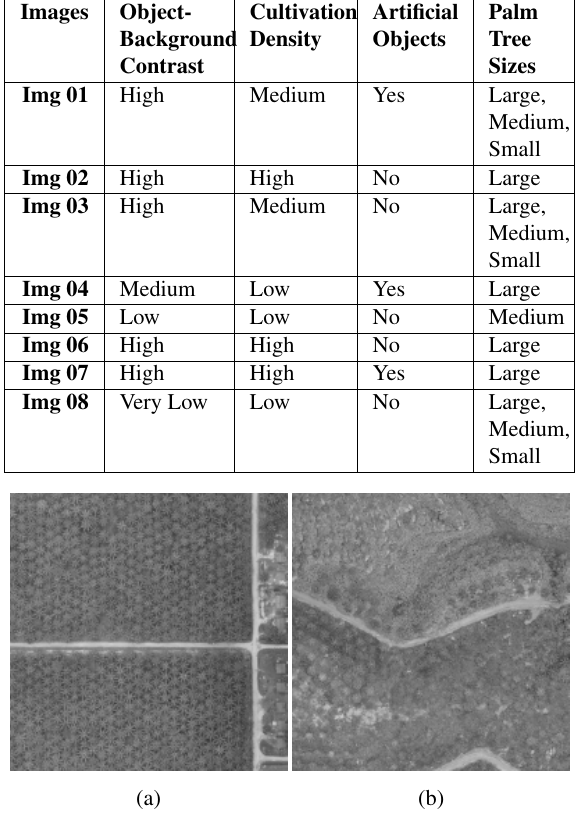
Table 1: Test image sets & their properties